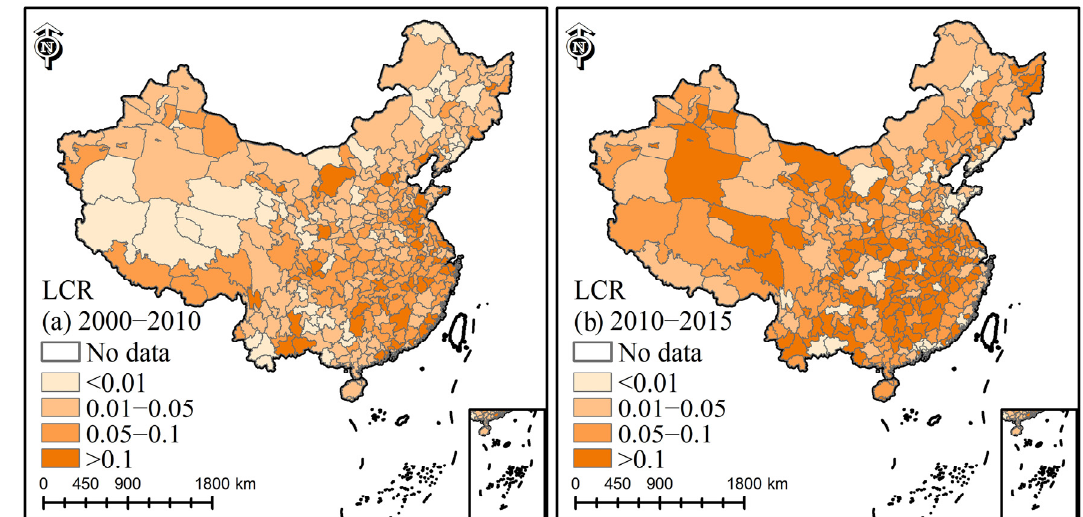
Figure 5. The spatial distribution of land consumption rate (each polygon shape (city) is attached with a color, which represents the city’s LCR value). Table 2. The classification average results of land consumption rate.